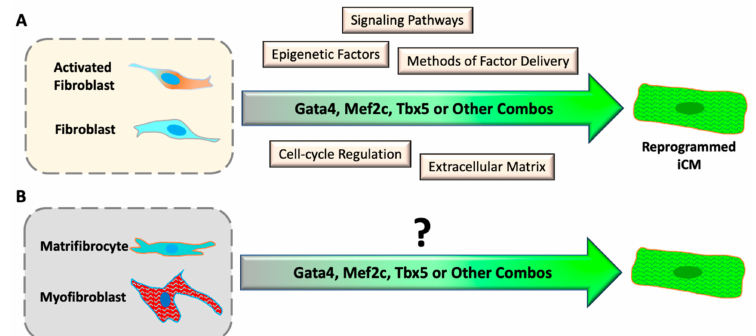
Figure 2. Progresses and challenges of direct cardiac reprogramming in vitro . ( A ) Understanding the mechanism of iCM reprogramming with cultured inactive and activated fibroblasts. ( B ) It is unknown if di ff erentiated myofibroblasts and matrifibrocytes can be reprogrammed into